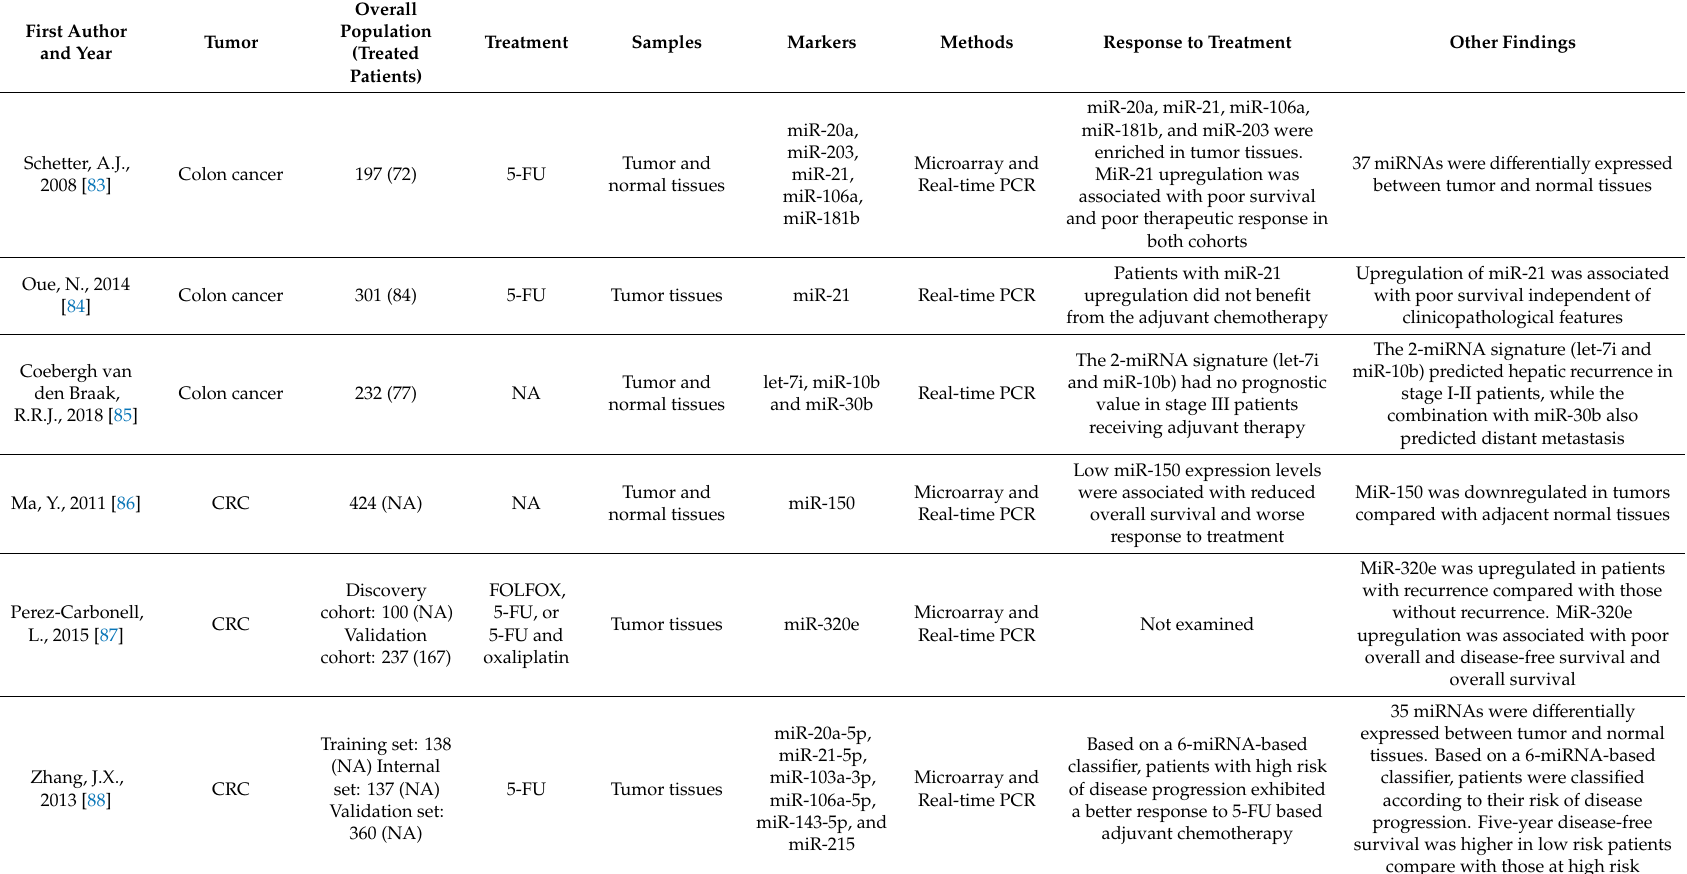
Table 7. MiRNA signatures in patients receiving adjuvant